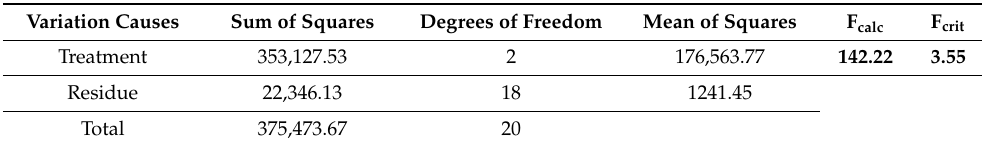
Table 4. Analysis of variance of Izod impact energy for epoxy composites reinforced with 0, 20 and 40 vol% of arapaima scales.